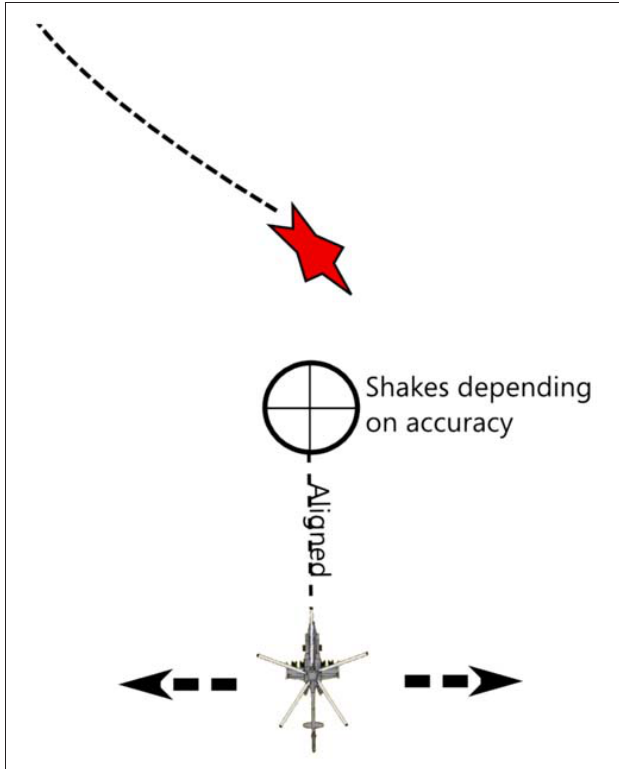
FIGURE 9 | Helicopter game concept: the user needs to collect the stars while benefiting from feedback and feedforward options to learn to play the game via